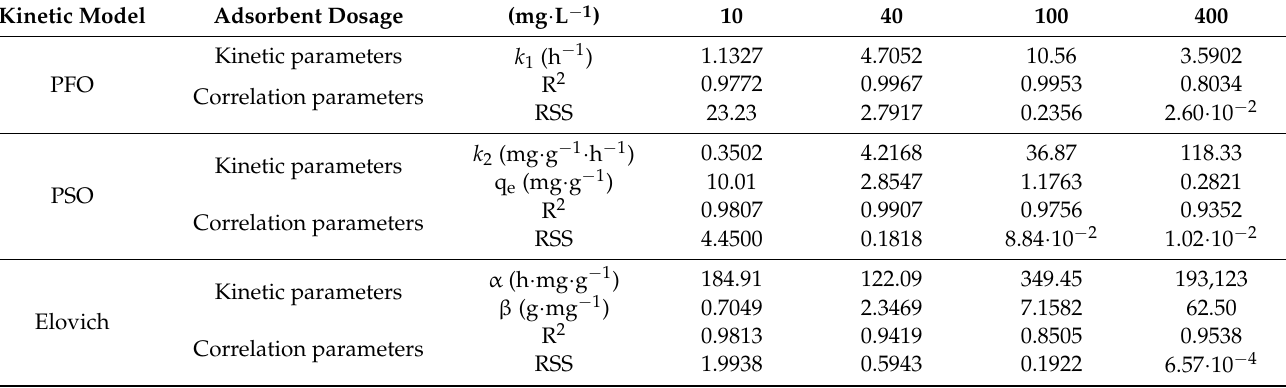
Table A2. Adjusted kinetic and correlation parameters of different kinetic models fitted to